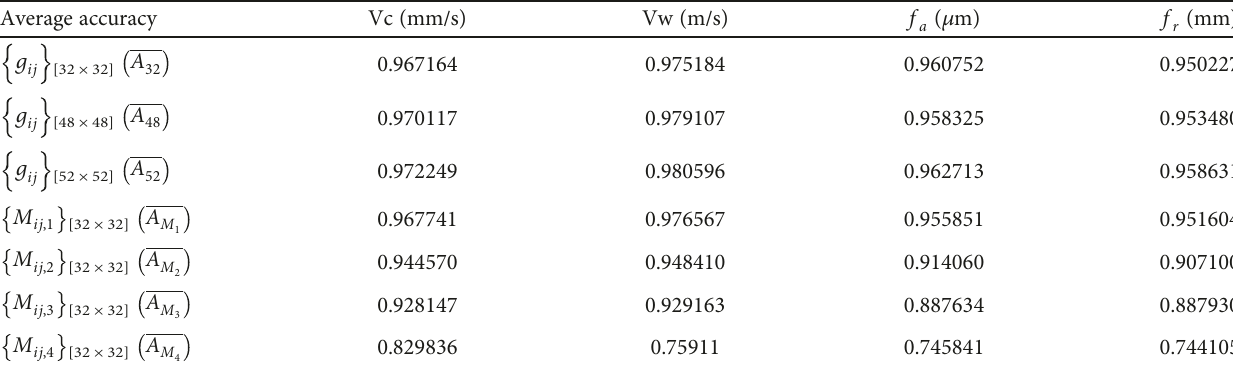
Figure 18: Predicted results of radial displacement of grinding wheel. Table 1: Average accuracies of predicted results with